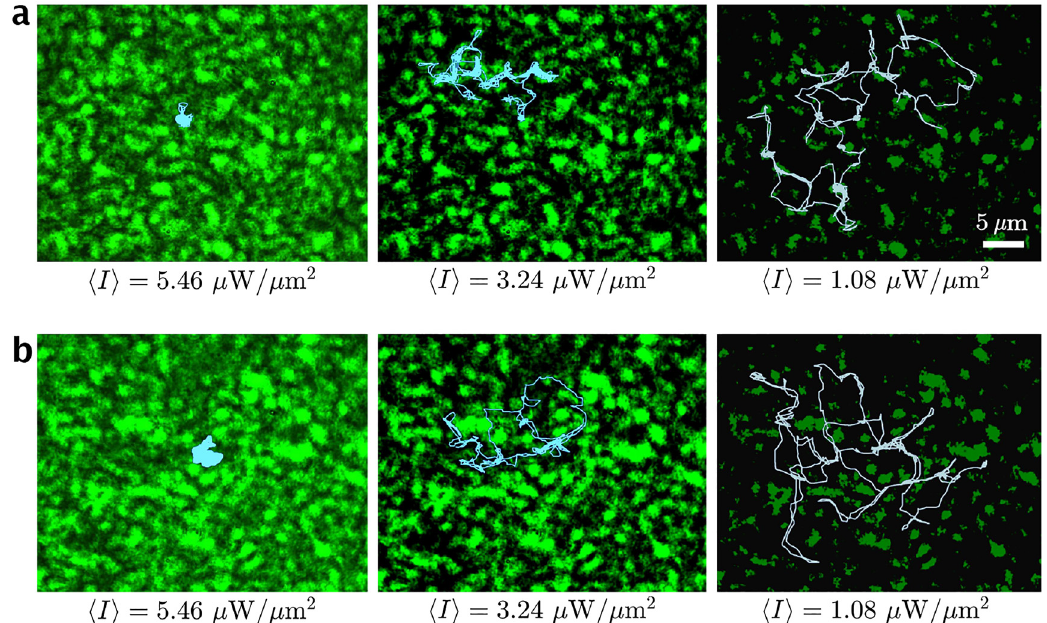
Figure 2: The experimental trajectories (turquoise solid lines) of high- and low-refractive-index (with respect to their surrounding) particles in regressive confinement through decreasing the average speckle intensity ( ⟨ I ⟩ = 5 . 46 μ W/ μ m 2 , ⟨ I ⟩ = 3 . 24 μ W/ μ m 2 , ⟨ I ⟩ = 1 . 08 μ W/ μ m 2 ) = 1 . 33, viscosity of 𝜂 = 0.001 N s ∕ m 2 at for the duration of 1000 s. The surrounding medium is distilled water of refractive index n m w temperature T = 300 K. The background represents the speckle field generated by propagating of a solid state laser light through a = 1 μ m and refractive index of n = 1 . 59. (b) Trajectories of a multimode fiber. (a) Trajectories of a polystyrene particle of diameter D p p = 1 μ m and refractive index of n = 1 . liposome vesicle of diameter D l l